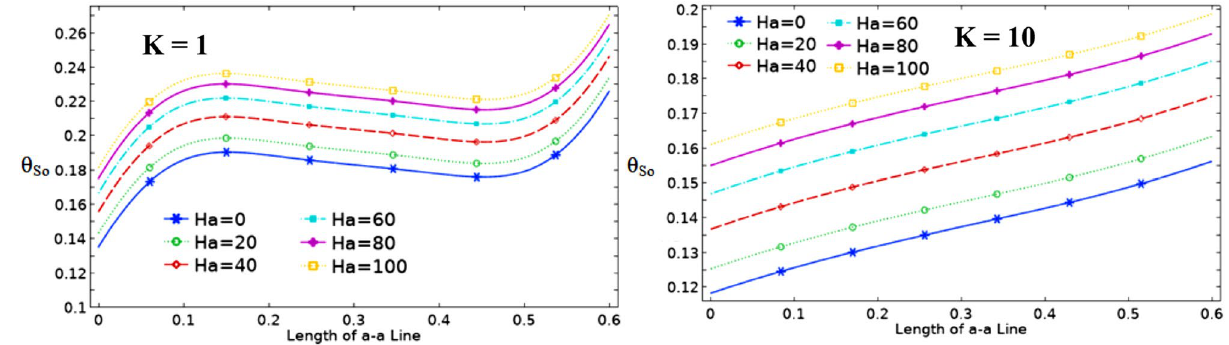
Figure 11. Dimensionless temperature along line a-a for different Hartmann numbers at Ra = 10 6 , Ω = 500, and λ = 0.52.